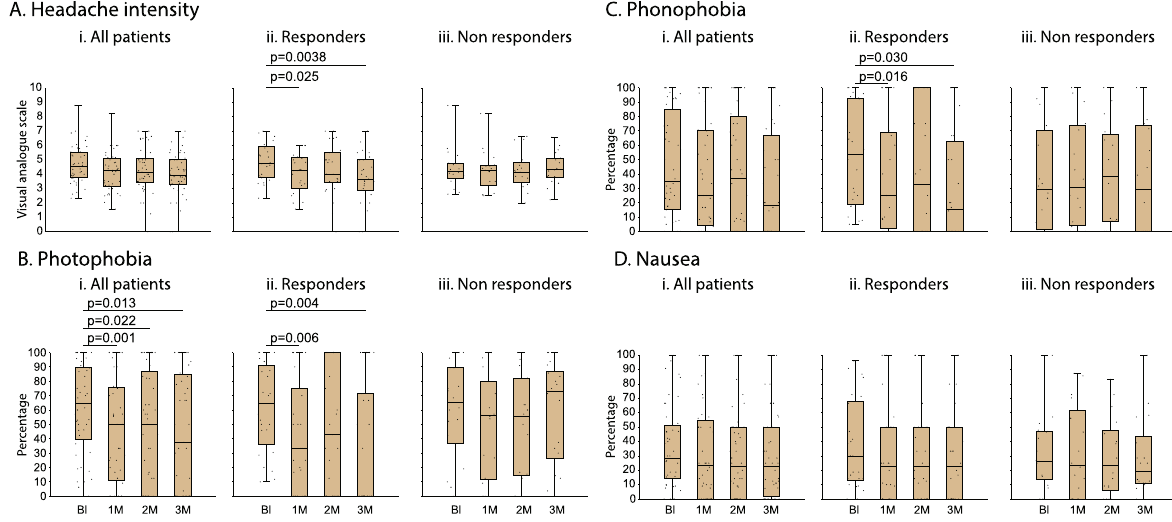
Fig. 5 Headache intensity ( A ) and incidences of photophobia ( B ), phonophobia ( C ), and nausea ( D ) during migraine attacks. Box‑and‑whisker plots (median [IQR]) combined with scatterplots of individual values are illustrated for each of the 4 periods (baseline and during the 3 months treatment). Note that in spite of the decrease in migraine days per month (Fig. 4), the remaining post‑treatment attacks were mostly migraineous as indicated by the headache intensity and continuous presence of photophobia, phonophobia and nausea. Abbreviations: Bl ‑ baseline, 1M ‑ 1 month, 2M ‑ 2 month, 3M ‑ 3